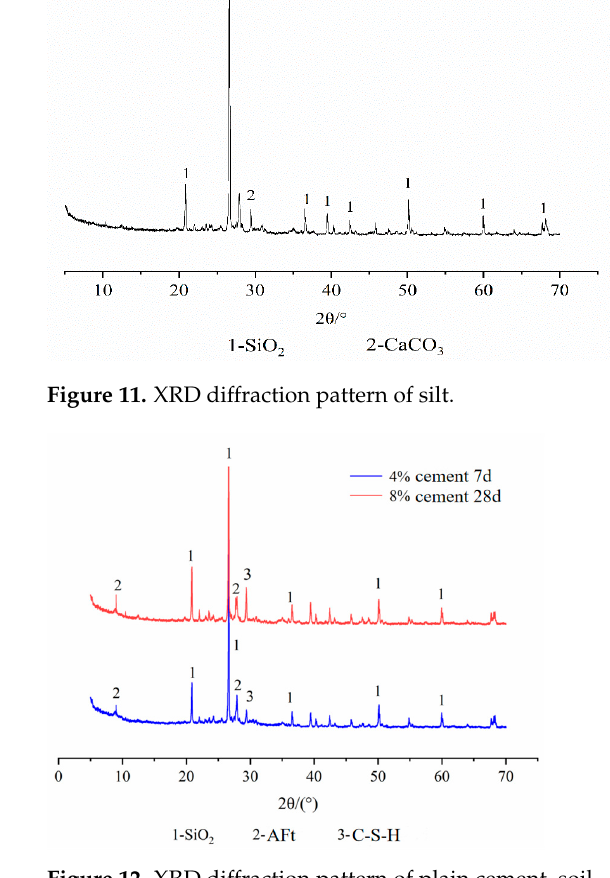
Figure 12. XRD diffraction pattern of plain cement–soil.